Question: Which visualization type does this figure use?
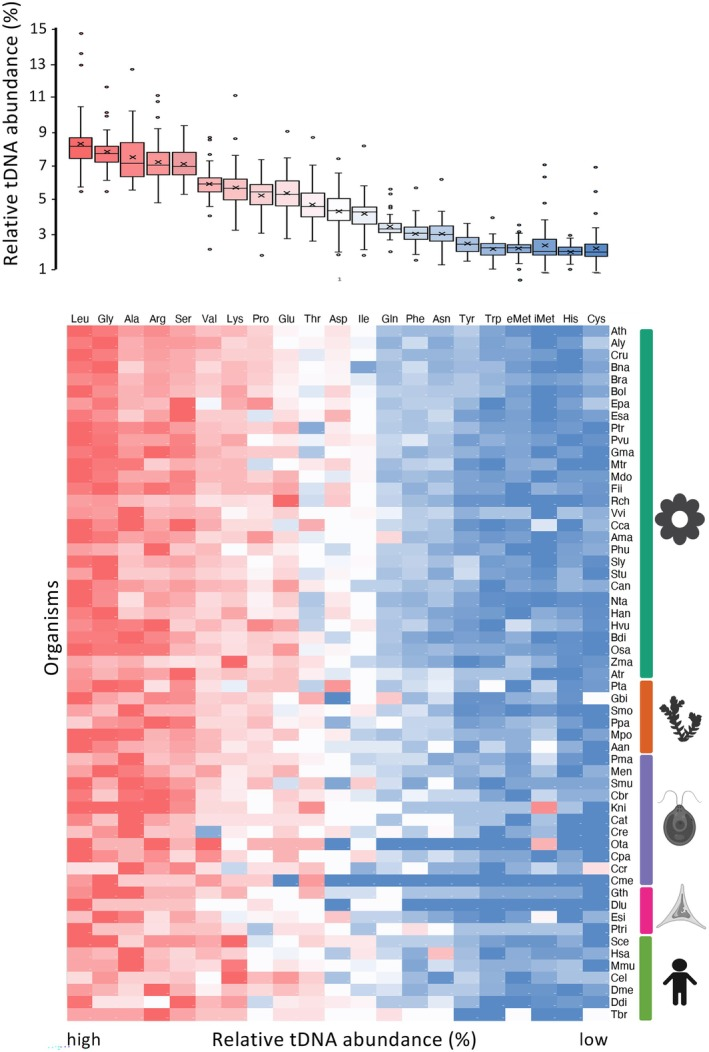
Answer: heatmap